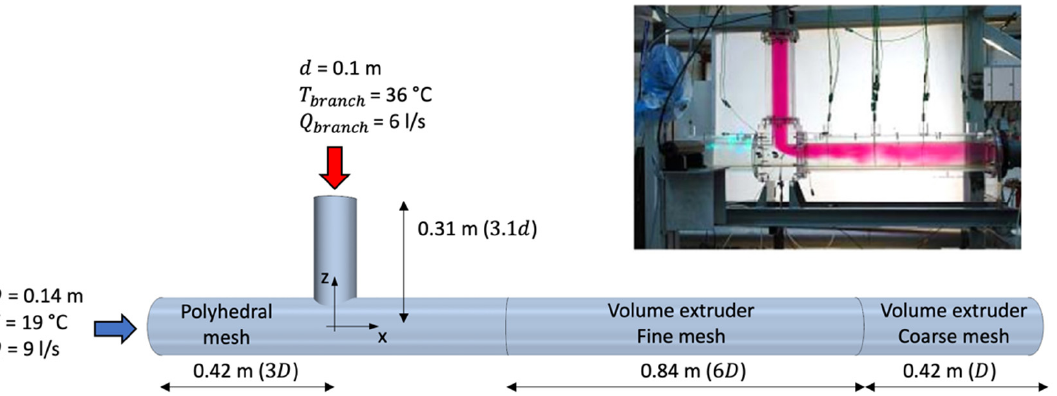
Figure 1. Side elevation schematic of the computational domain and photographic image of the Vat- tenfall test rig. Reproduced with permission from ref. [24]. Vattenfall test rig. Reproduced with permission from ref.